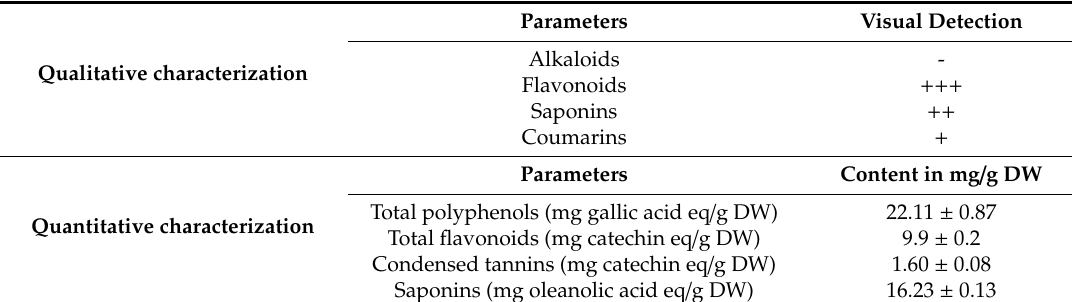
Table 2. Qualitative and quantitative phytochemical characterization of AFSEE, determined using colorimetric and spectrophotometric methods.